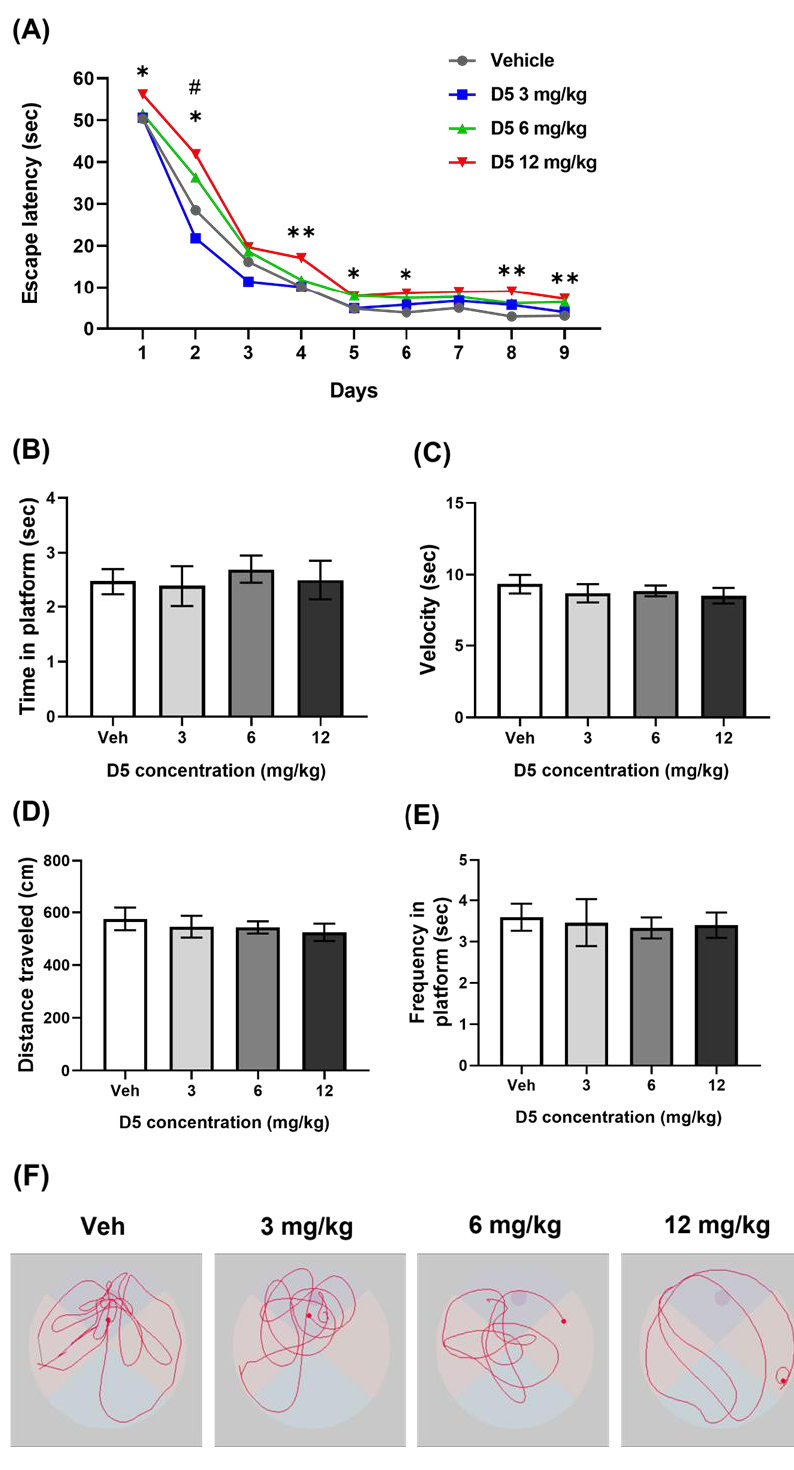
Figure 7. Effect of D5 exposure on learning ability in offspring mice: ( A ) Time escaping to the latency platform; ( B ) bar graph of the time to reach the location where the platform was; ( C ) bar graph of the velocity of mouse traveling to the experimental pool; ( D ) bar graph of distance traveled; ( E ) bar graph of the frequency of mouse entering the location where the platform existed; ( F ) image of the mouse movement tracking. Significance was obtained using ANOVA test. * p < 0.05, ** p < 0.01, 12 mg/kg vs. vehicle. # p < 0.05, 6 mg/kg vs. vehicle. Each value is expressed as the means ± SEM. Vehicle ( n = 20), D5 3 mg/kg/day ( n = 14), D5 6 mg/kg/day ( n = 33), and D5 12 mg/kg/day ( n = 30). Veh,